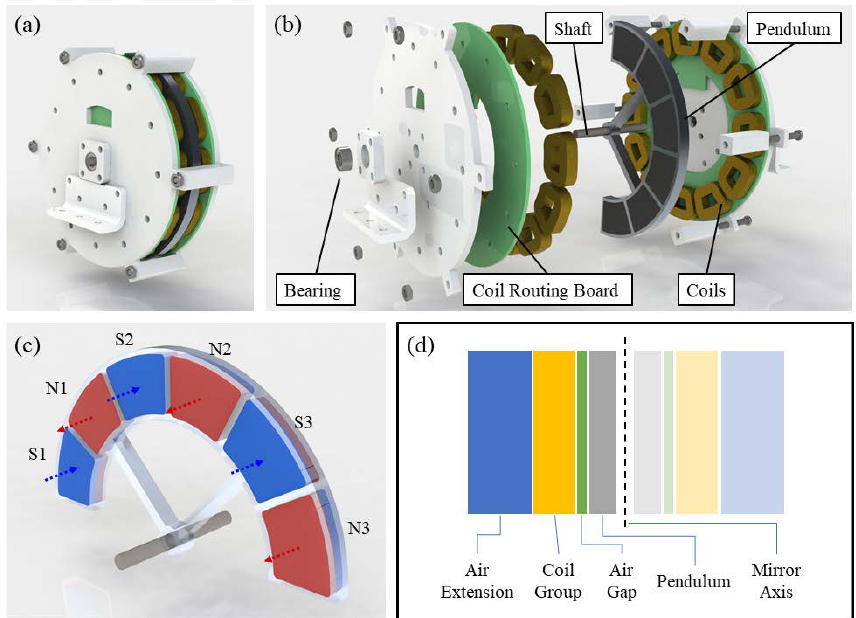
Figure 1. Structure design of a low-frequency vibration energy harvester: ( a ) assembly diagram of an energy harvester; ( b ) explosive view of an energy harvester; ( c ) magnetic field configuration for the eccentric rotor; ( d ) framework diagram of the finite element analysis (FEA) model.